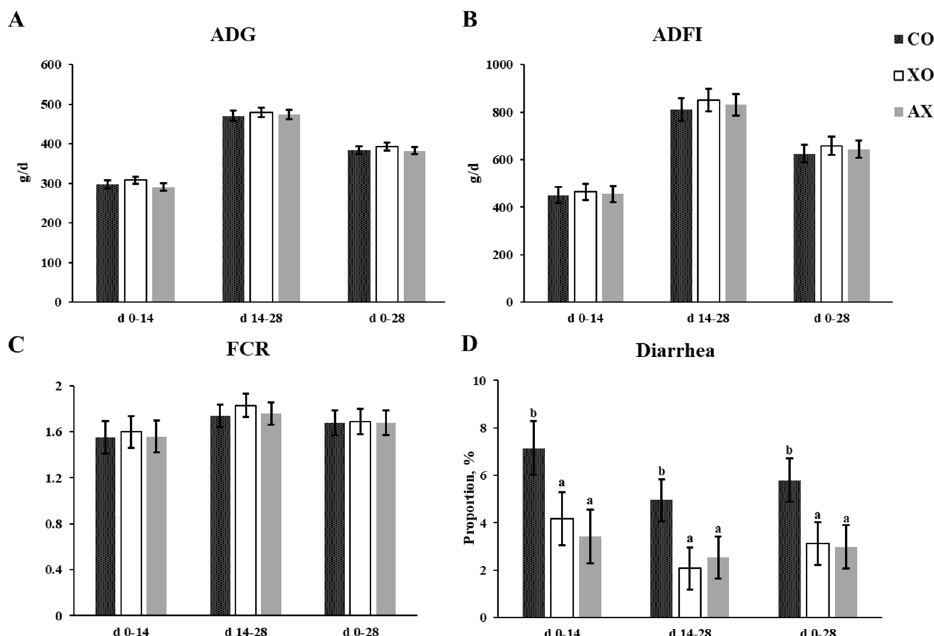
Figure 1. Effects of xylo-oligosaccharides and arabinoxylans on growth performance of weaned pigs. Note: ( A ) ADG, average daily gain; ( B ) ADFI, average daily feed intake; ( C ) FCR, feed conversion ratio; ( D ) diarrhea. Note: a, b, significant differences ( p < 0.05) between different letters in the same row of shoulder labels (n = 6); CON, a control diet; XOS, a diet containing 1% xylo-oligosaccharide; AX, a diet containing 1% arabinoxylans; SEM, standard error of the mean.